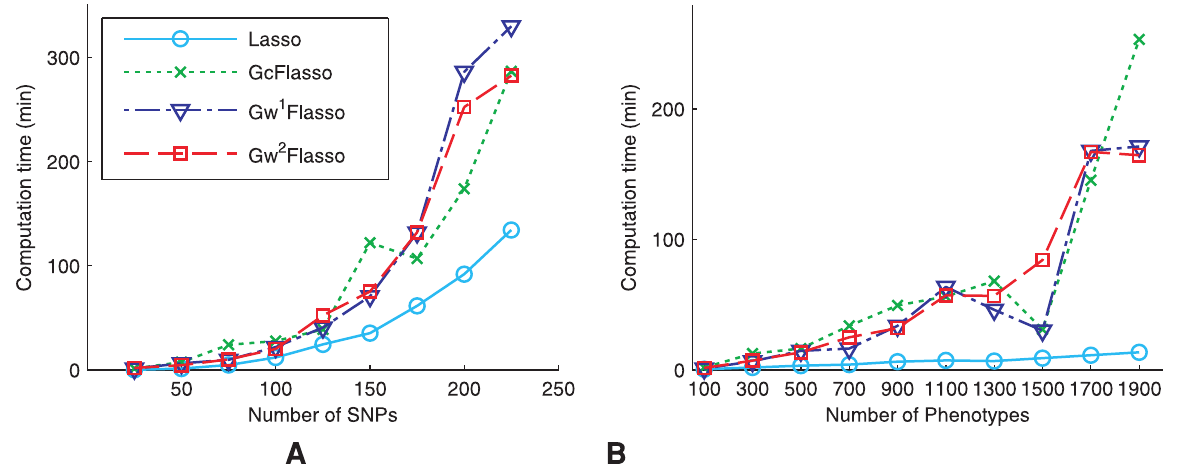
Figure 10. Comparison of the computation time for lasso, G c Flasso , G 1 number of phenotypes fixed at 250. (B) We varied the number of phenotypes with the number of SNPs fixed at 50. The QTNs were obtained using threshold r ~ 0 : 3 . The number of edges in the QTNs ranged from 900 to 950 in each case.